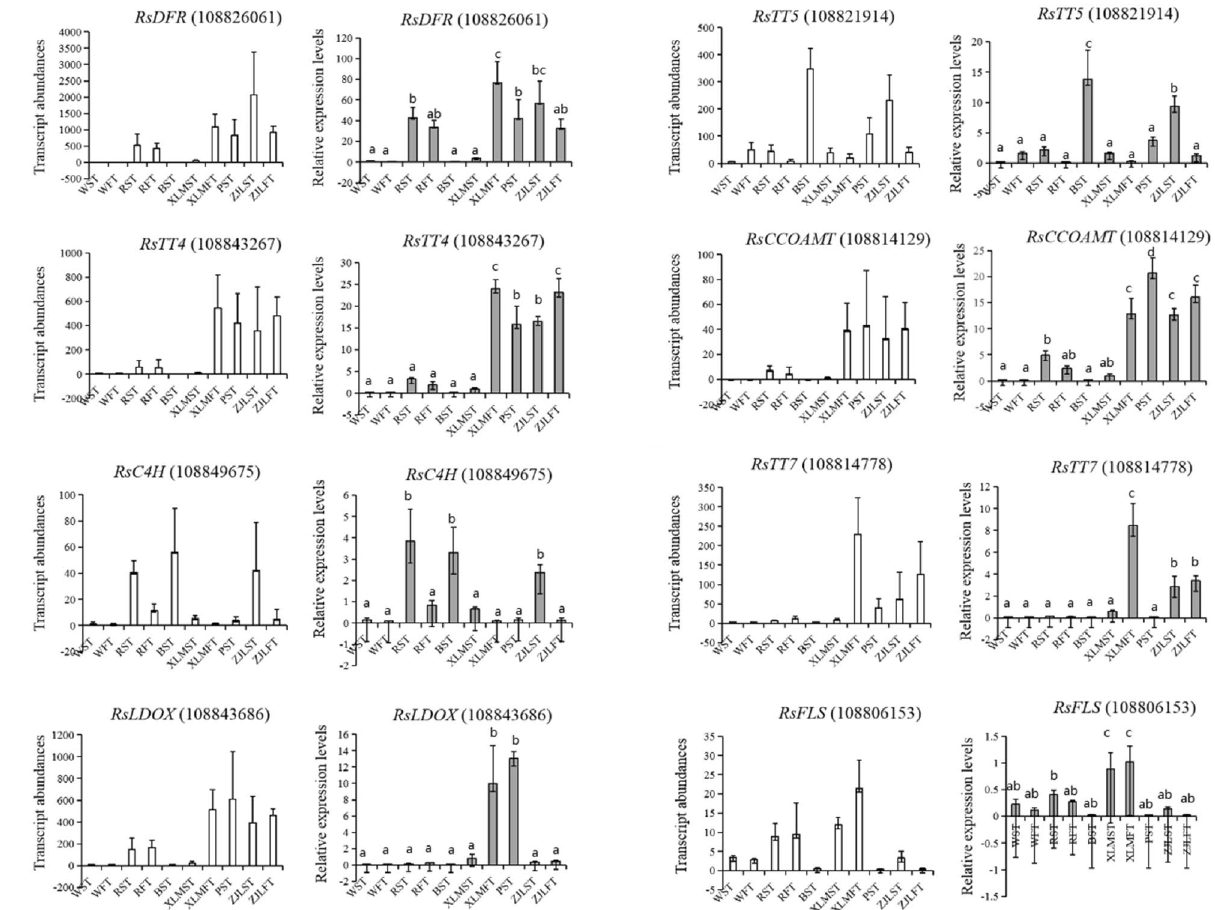
Figure 6. Validation of the transcriptomic data using RT-qPCR. Transcript abundances detected by transcriptome sequencing and expressed in FPKM are shown on the left. Relative expression levels detected by RT-qPCR and expressed in 2 −ΔΔCT are shown on the right. Data are presented as the mean of three replicates with three biological repeats. The significant differences among samples were evaluated by Dunnett’s test at P <